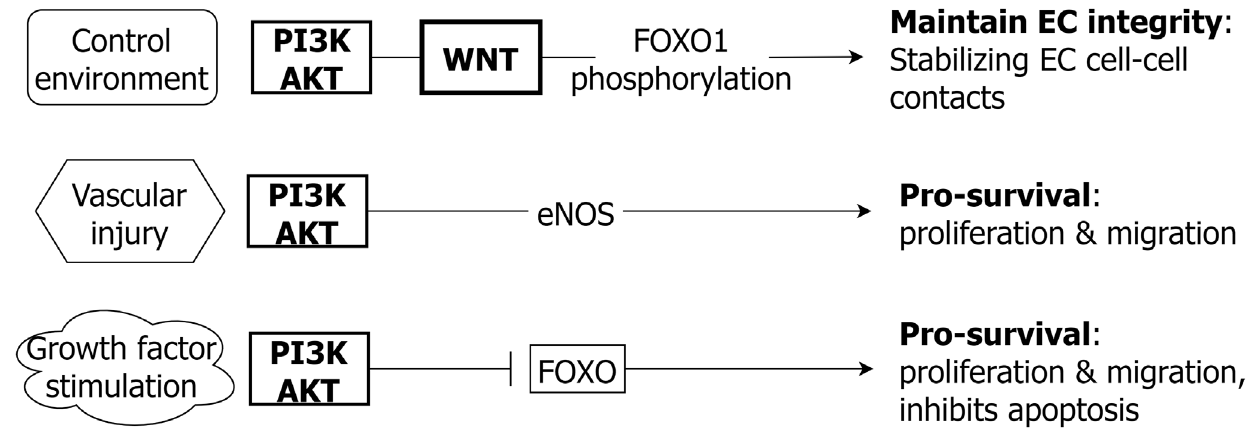
Figure 6. Summary of the mechanisms of PI3K/AKT signaling pathway in endothelial cells. In the basal state, AKT signaling is associated with stability of EC and cell junctions. In response to growth factors, or vascular injury, upregulated AKT activity is associated with EC proliferation.